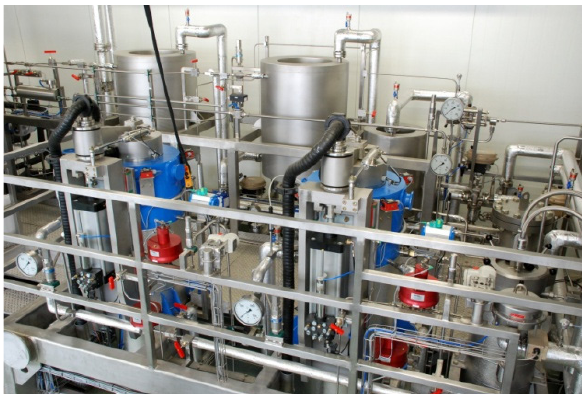
Figure 2: Pilot plant that was used in this